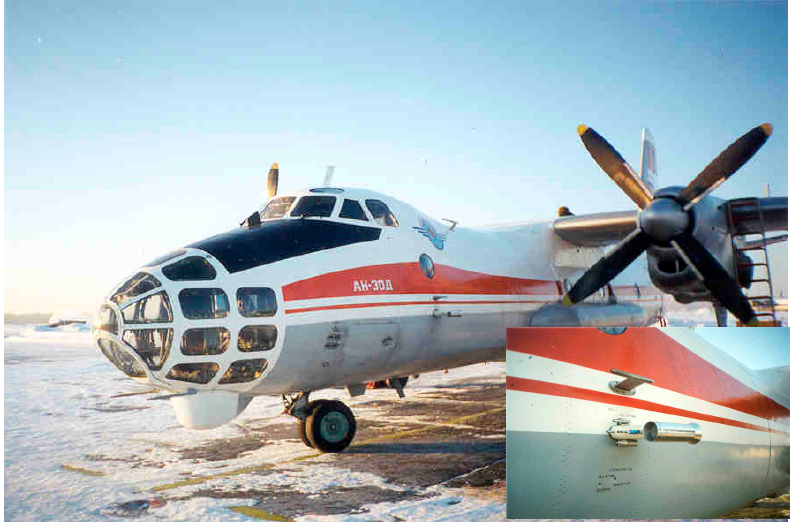
Figure 1. Photo of Antonov-30 aircraft. Insert is the samplers’ inlets.